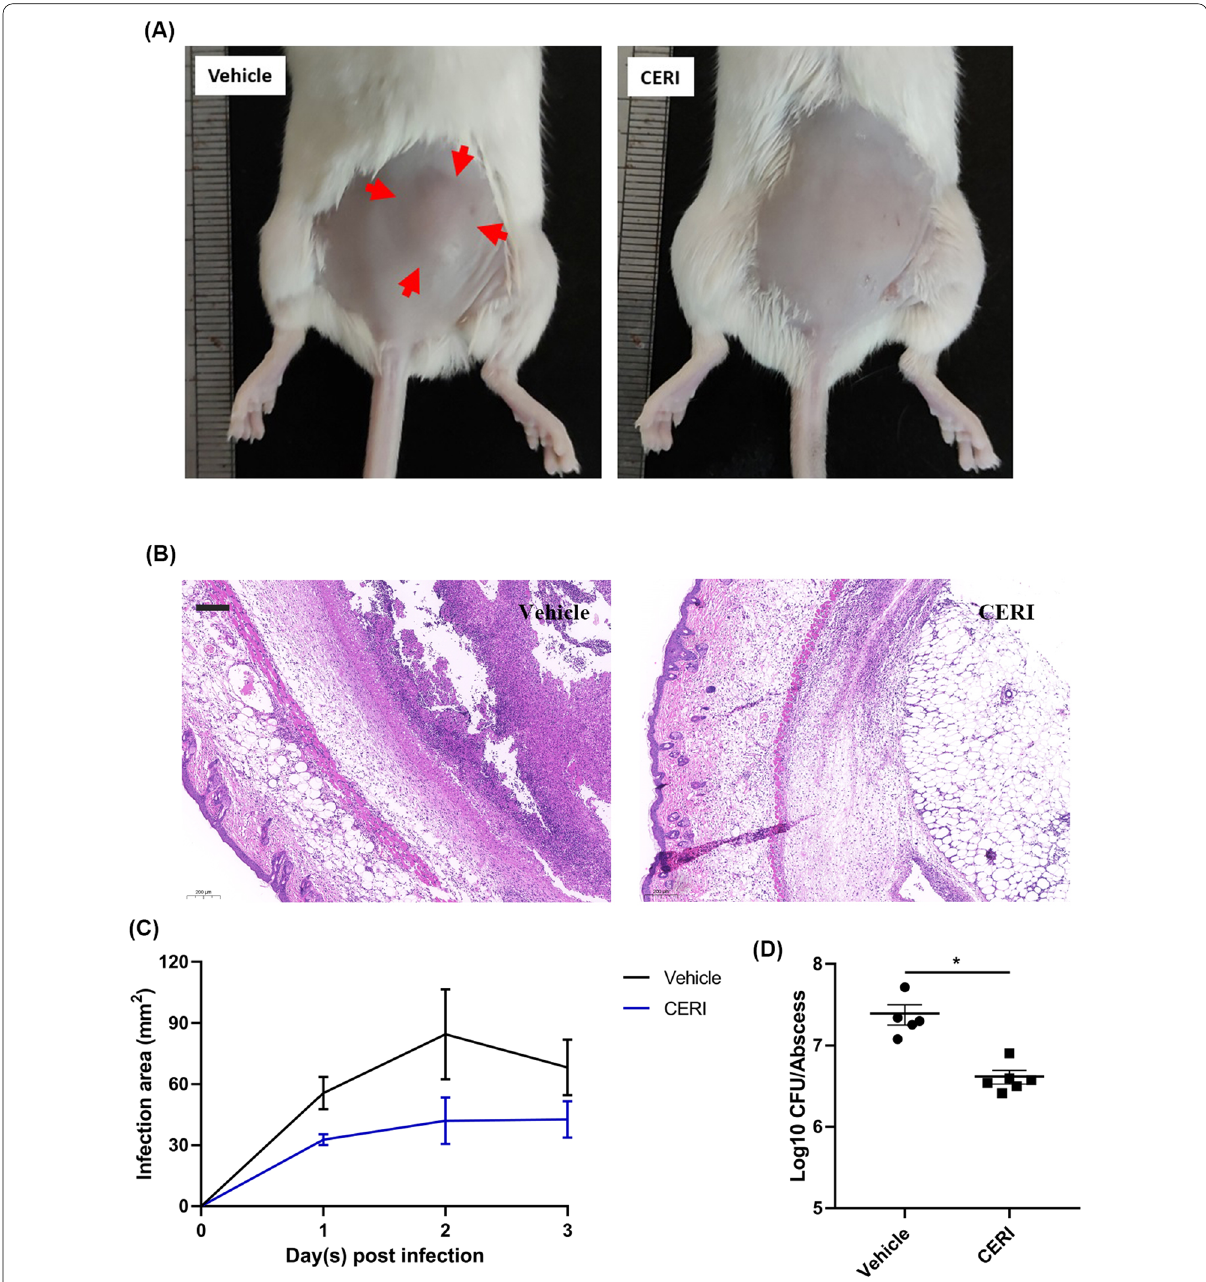
Fig. 4 The in vivo antimicrobial activity of CERI in a subcutaneous abscess mouse model. A Photographs of subcutaneous abscesses in the vehicle- and CERI-treated groups on the third day post-treatment. Red arrows indicate the boundary of the abscess. B H&E staining of abscess tissues treated with vehicle or CERI. Scale bars, 200 μm. C Abscess area quantification post infection. D Bacterial load quantification in the abscess. Each group has six mice. The assays were repeated three times independently, and the results were presented as mean considered significant when * P <